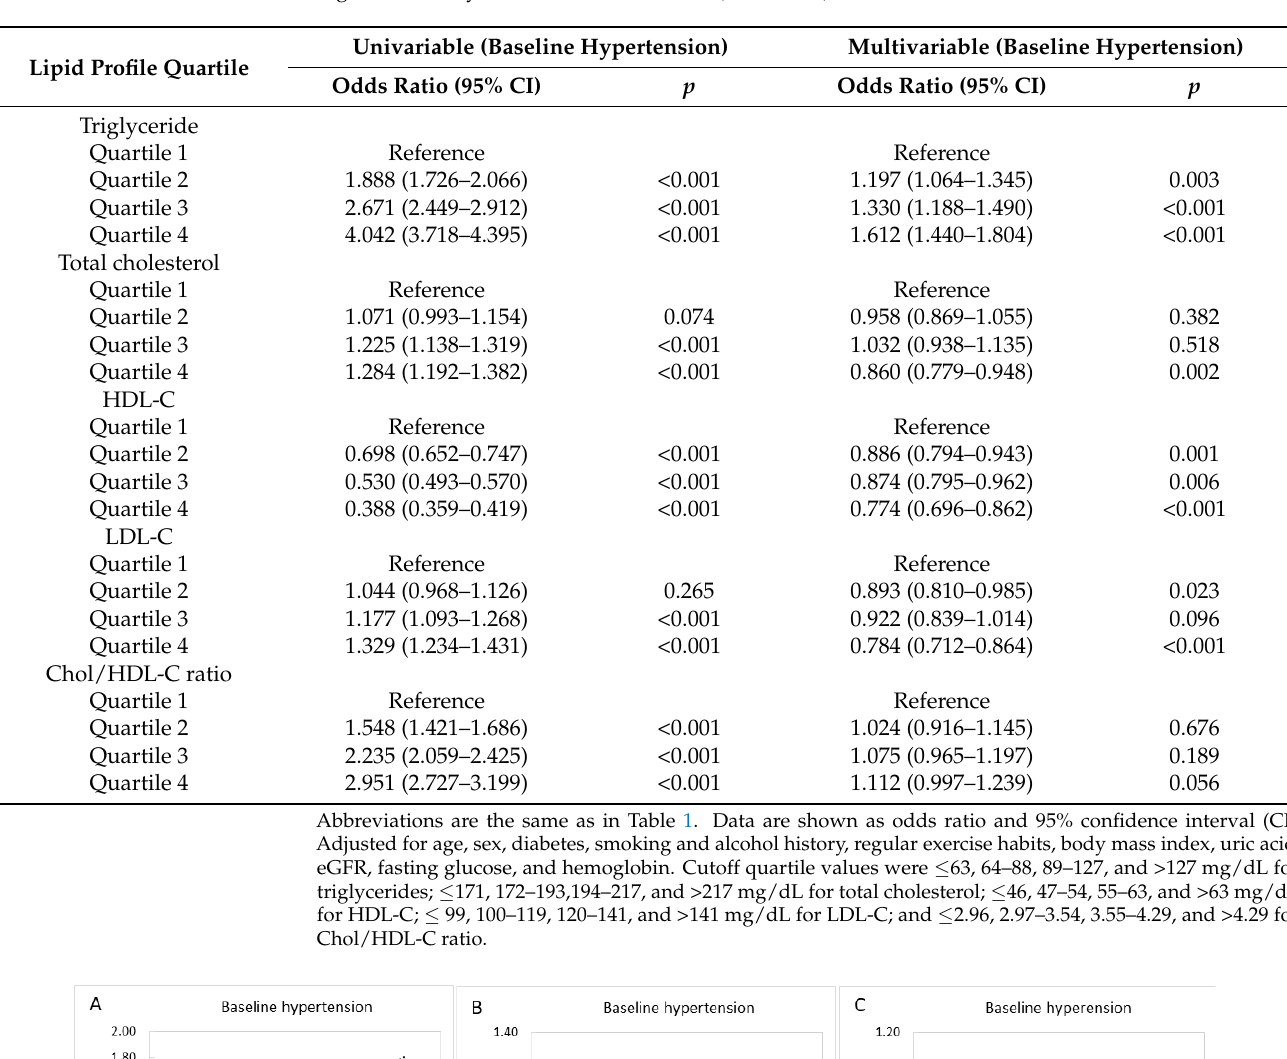
Table 2. Associations of lipid profile quartiles with baseline hypertension according to logistic regression analysis for the whole cohort ( n = 26,965).